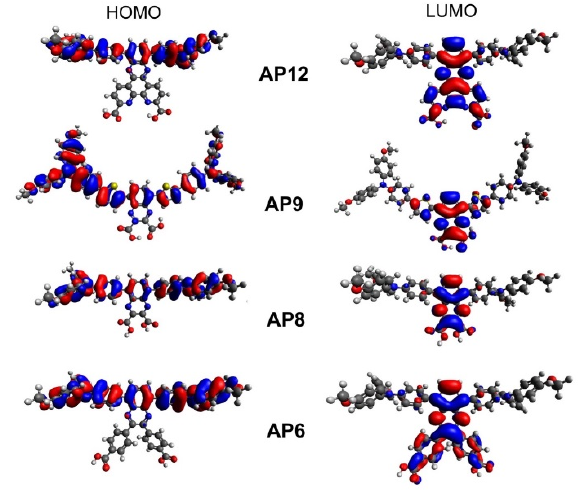
Figure 4. Frontier molecular orbital distributions of AP6 , AP8 , AP9 , and AP12 .